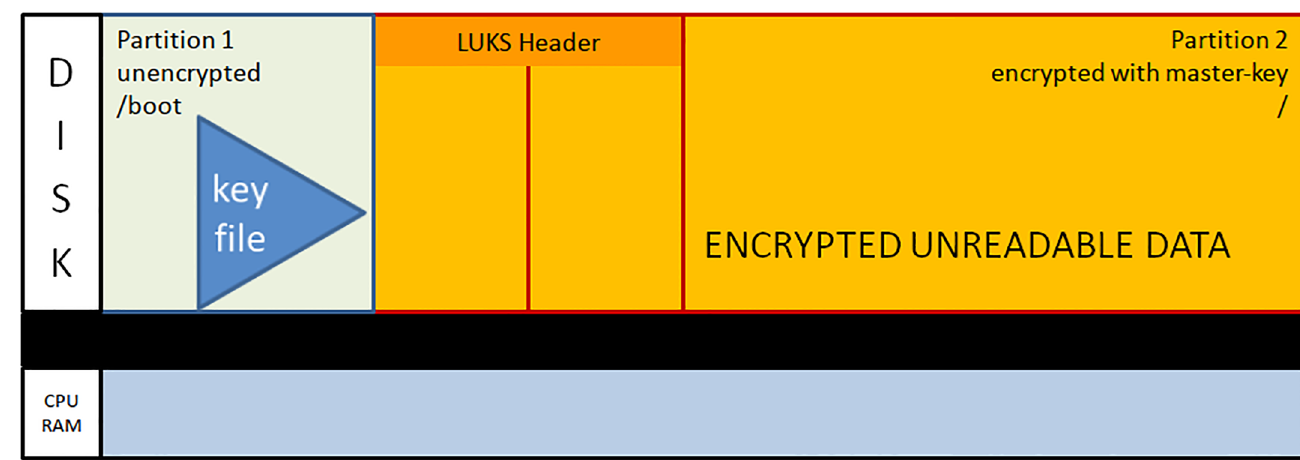
Fig 5. Inaccessible disk state after reboot or power down.